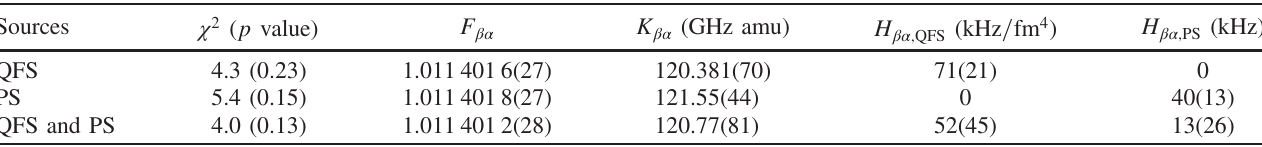
TABLE VIII. Best-fit parameters with transition pairs ð λ 1 ; λ 2 Þ ¼ ð α ; β Þ . The error of each fit parameter is evaluated as 1 σ .